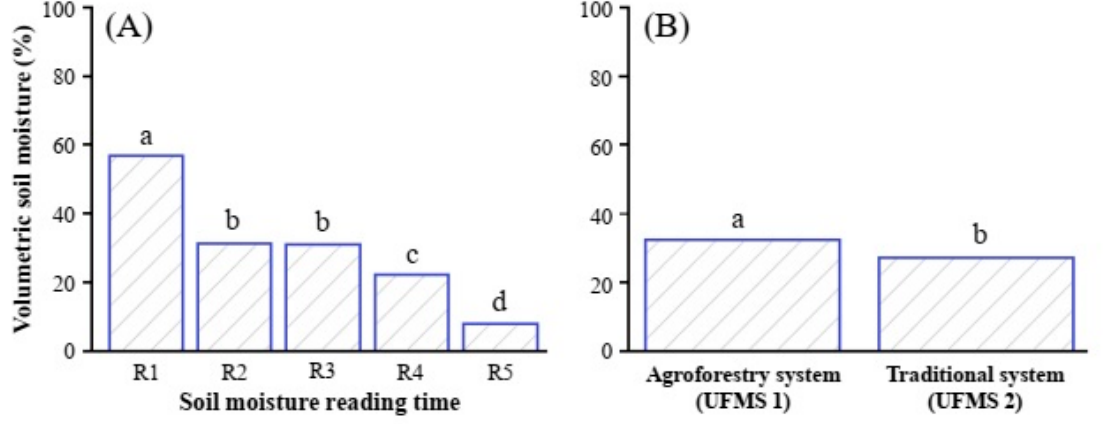
Figure 7. Soil moisture content measured during the developmental stages of off-season corn crop grown in two agricultural production systems (agricultural area with (agroforestry system—UFMS 1) and without (traditional system—UFMS 2) direct effect of the eucalyptus forest) in Chapad ã o do Sul, MS, Brazil during the 2019 growing season. R 1 , R 2 , R 3 , R 4 , and R 5 represent the soil moisture readings performed on 21 February, 8 March, 8 April, 22 April, and 21 May 2019, respectively. Bars followed by distinct letters show significant differences by Tukey’s test ( p < 0.05). Corn crop development ( A ). Traditional production system ( B